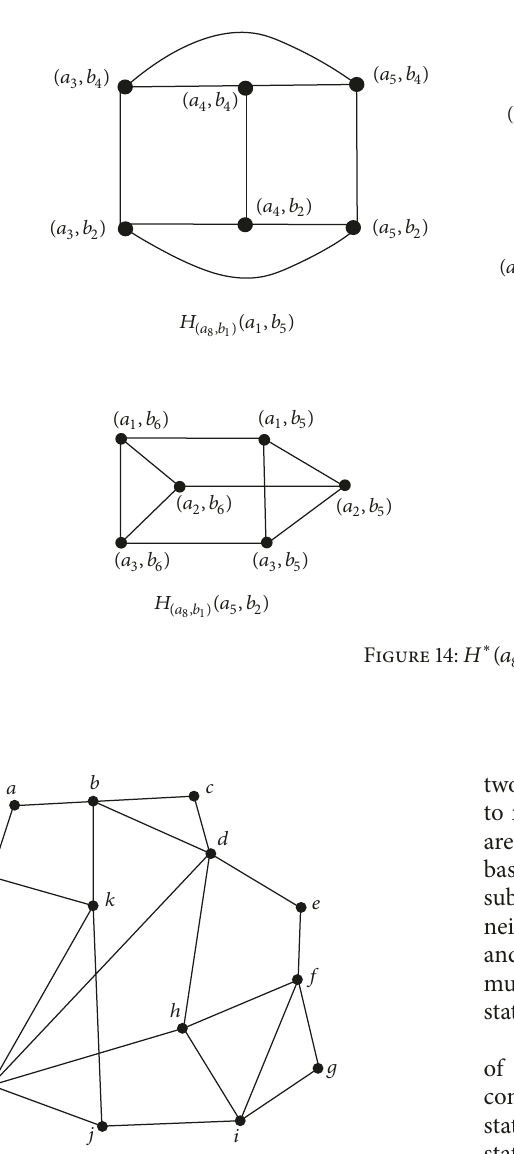
Figure 15: Communication